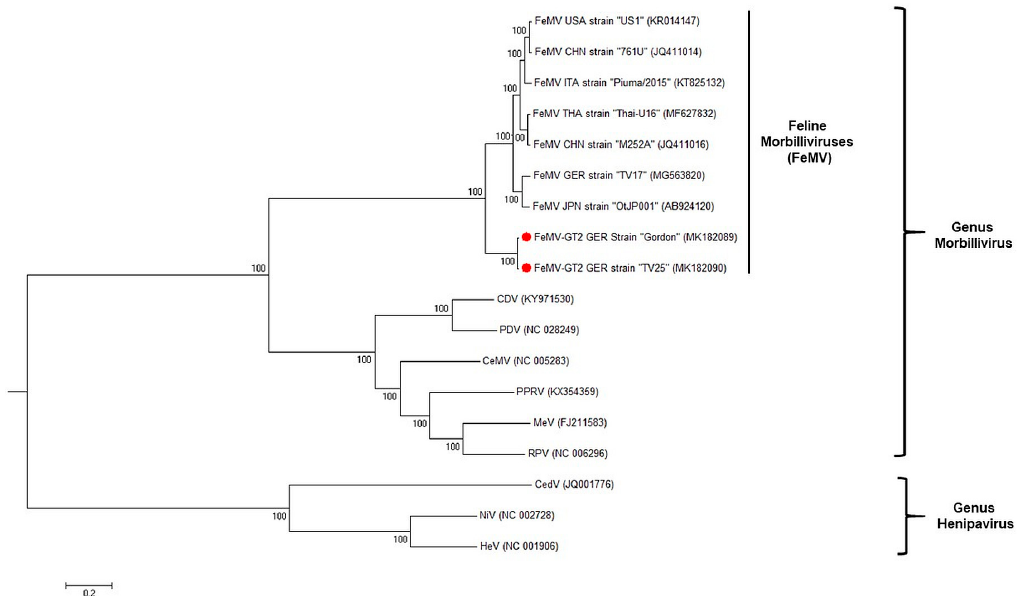
Figure 3. Phylogenetic tree of paramyxoviruses constructed from whole genome sequences. Strains identified in this study were highlighted in red. Scale bar indicates 0.2 nucleotide substitutions per site. Accession numbers of paramyxovirus species included in the phylogenetic analysis are shown in brackets. Abbreviations: CDV = canine distemper virus, PPRV = peste-des-petits-ruminants virus, MeV = measles virus, RPV = rinderpest virus, CeMV = cetacean morbillivirus, PDV = phocine distemper virus, CedV = Cedar Virus, NiV = Nipah Virus, HeV = Hendra Virus.